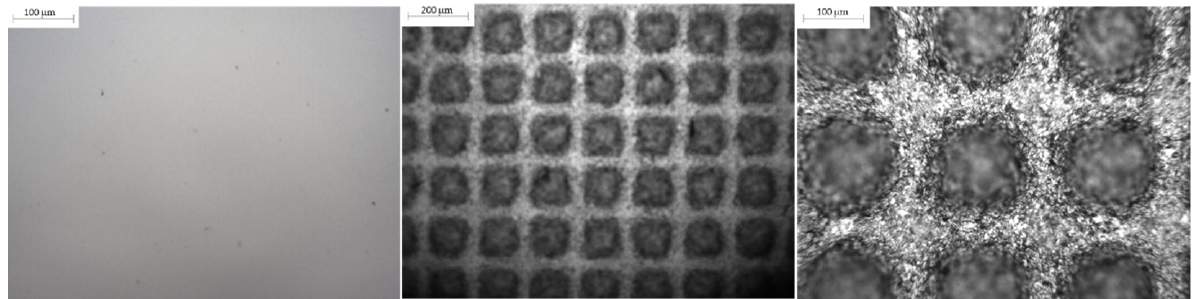
Figure 2. Microscope images of the smooth glass ( left ) and rough glass at different magnifications ( middle and right ), respectively. Scale bars (from left to right ) represent 100, 200 and 100 µm.